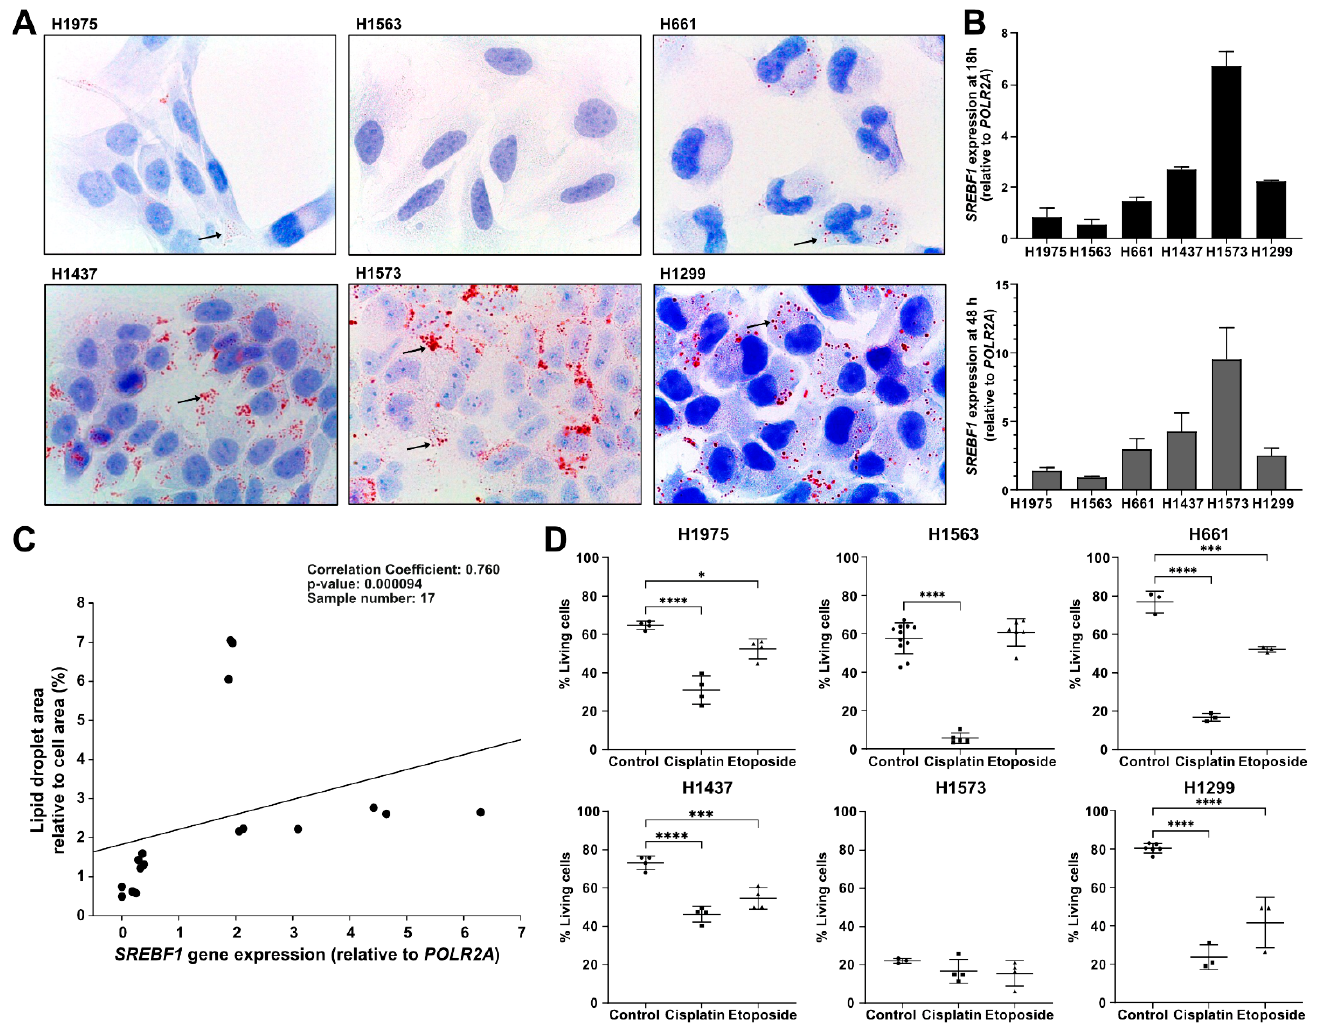
Figure 1. Lipid droplet formation, SREBF1 gene expression, and viability assay in six lung cancer cell lines. ( A ) Lipid droplets were stained with Oil red O and nuclear components with hematoxylin after cell culture in BM for 18 h. Arrows indicate lipid droplets. Images were taken at 1000-fold magnification using a 100× oil immersion objective (Leica). One representative experiment out of three independent experiments is shown. ( B ) Six cell lines were incubated in BM for 18 h or 48 h before RNA isolation and analysis for SREBF1 expression. Gene expression was carried out in du- plicate from three independent experiments and data are presented as mean (SD). ( C ) The correla- tion between the LDs ( A ) and SREBF1 expression ( B ) was performed by using Spearman’s correla- tion, n = 17 resulting from two or three independent experiments per cell line from a total of six cell lines. ( D ) Cells were cultured in BM for 48 h with or without 20 µg/mL cisplatin or 100 µM etopo- side. The cell viability was assessed by Annexin V 7AAD Apoptosis Detection Kit. Living cells (%) were determined against nontreated controls for each medium separately. Number of independent experiments: n = 3 for H661, H1299 etoposide and cisplatin, H1573 control; n = 4 for H1975, H1437; n = 5 for H1563 cisplatin; n = 6 for H1299 control, H1563 etoposide; n = 11 for H1563 control. p -values of treatment vs. control cells were calculated with a one-way ANOVA. Data are presented as mean (SD). A p -value below 0.05 was considered as significant: * p < 0.05, *** p < 0.001, and **** p < 0.0001. BM, basal medium. 3.2. Morphological Characteristics of H1299 but Not H1563 Cells Change in Serum-Free Neutrophil Degranulation Medium (NDM) as Compared to Basal Medium (BM) For the following experiments, we chose two adenocarcinoma cell lines: H1299, es- tablished from a lung lymph node metastasis, and H1563 established from a lung adeno- carcinoma. H1299 cells abundantly formed LDs whereas H1563 did not show any traces